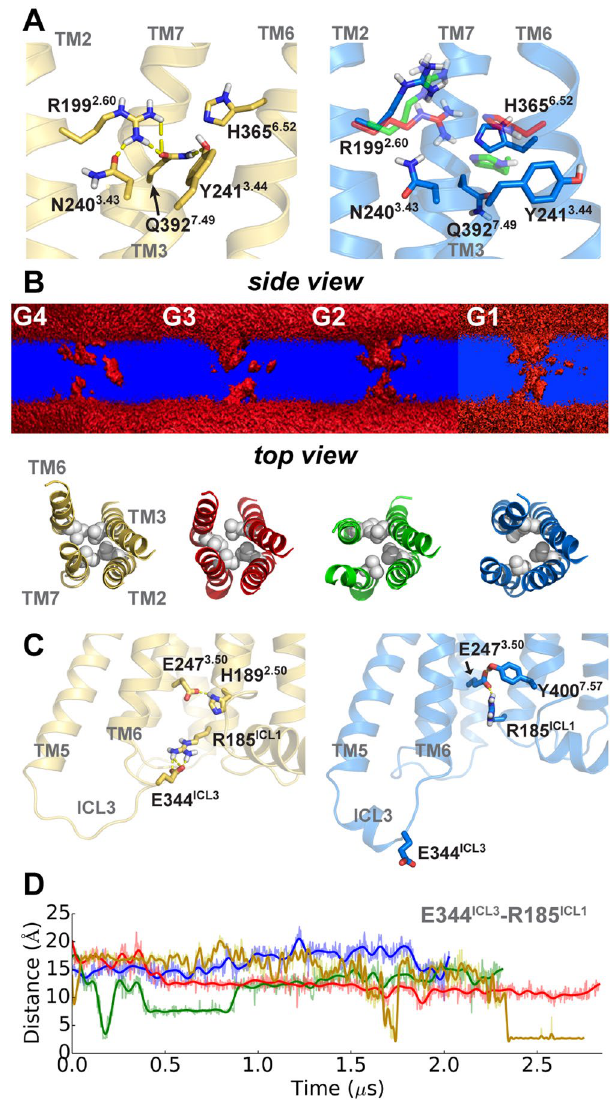
Figure 3. Interactions within the 7TM. ( A ) A H-bond network within the 7TM. ( B ) Water-density cross section with the hydrophobic region of L192 2.53 , L244 3.47 , L358 6.45 , and V396 7.53 (spheres). A penetration is suggested in G1 and G2. ( C ) The salt bridge E344 ICL3 -R185 ICL1 in two different states. ( D ) Time evolution of nearest polar atom distance in E344 ICL3 -R185 ICL1